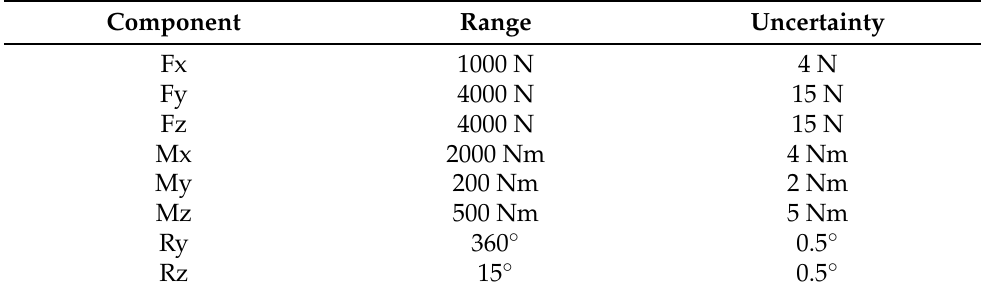
Table 2. Cavitation tunnel balance